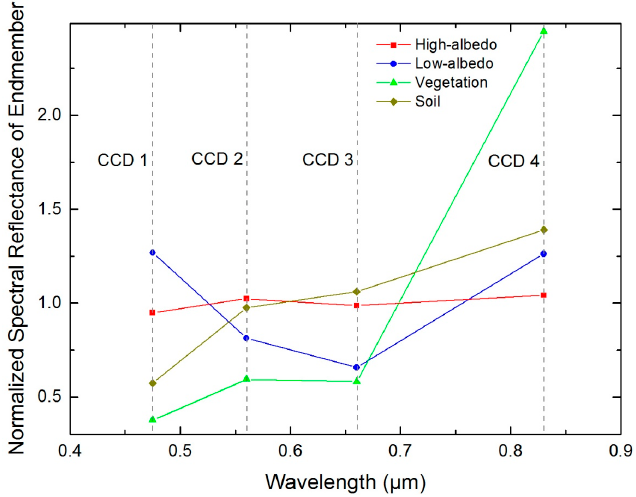
Figure 4. Normalized spectral reflectance for HJ-1 VNIR bands of the four selected endmembers.